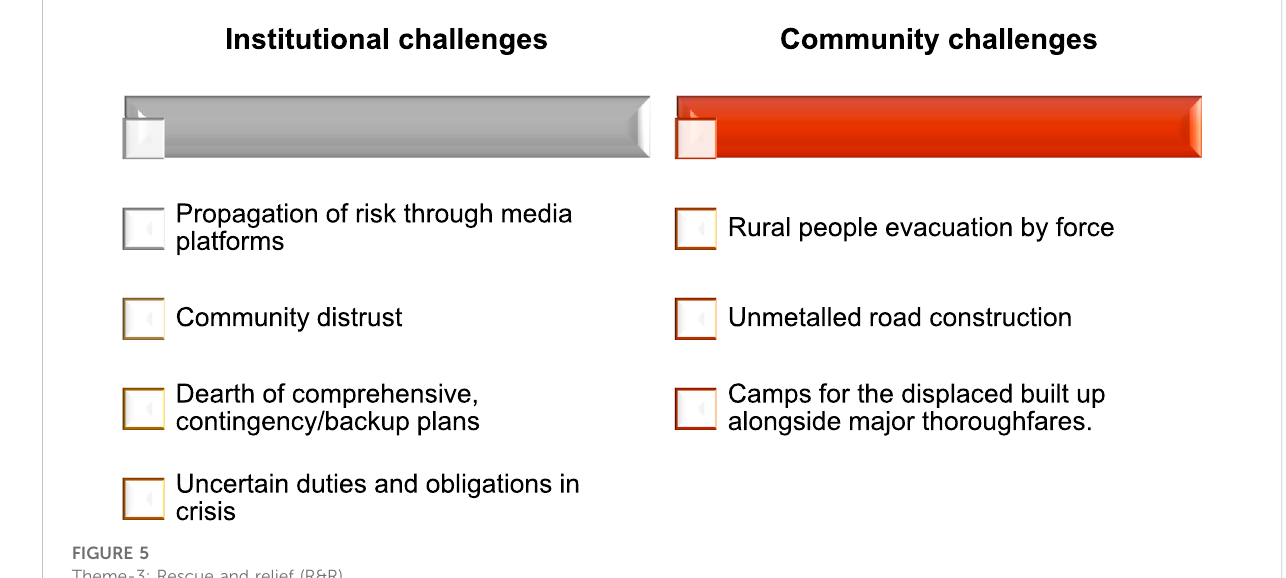
FIGURE 5 Theme-3: Rescue and relief